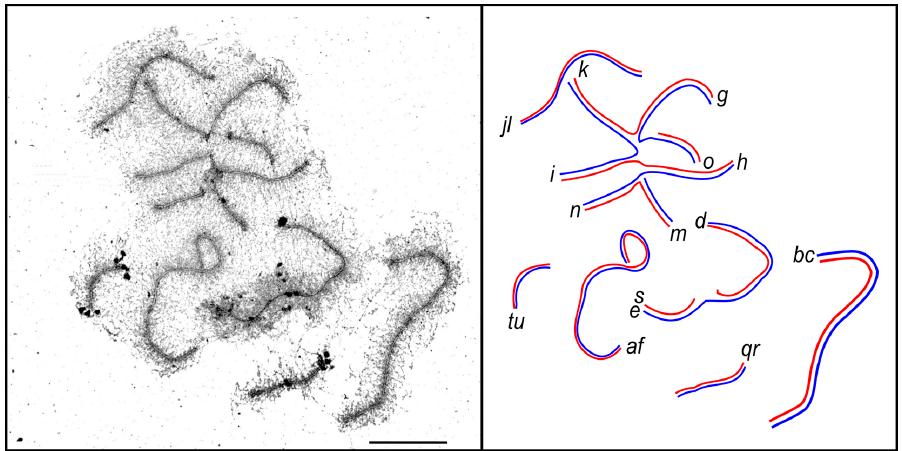
Figure 4. Electron micrograph and interpretative diagram of a pachytene spermatocyte of a CVIII heterozygote after AgNOR staining. Letters indicate chromosomes and chromosome arms. Scale bar: 5 µm.